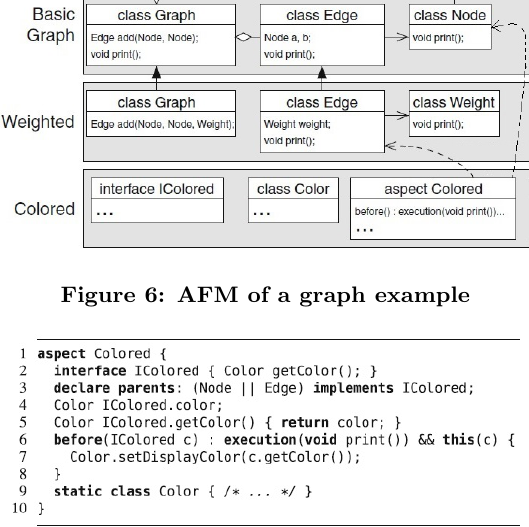
Figure 7: AspectJ code of aspect Colored for the graph example